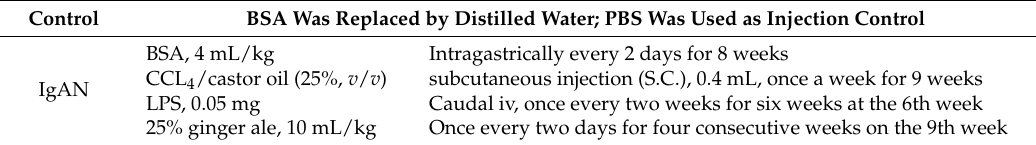
Table 2. Induction of IgAN in the SD